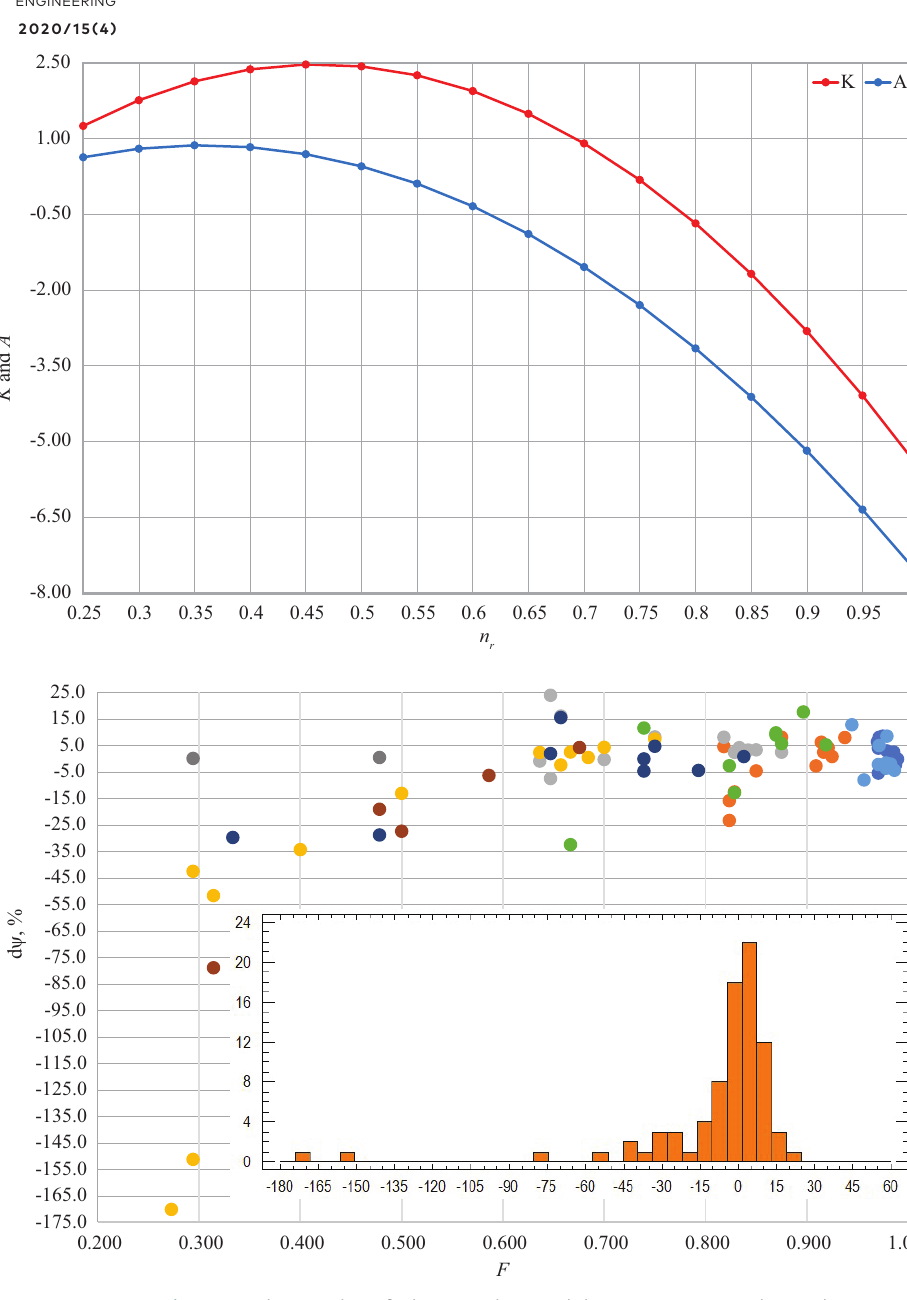
Figure 4. The results of plotting the model approximating dependence: a) empirical coefficients A and K ; b) model accuracy in the